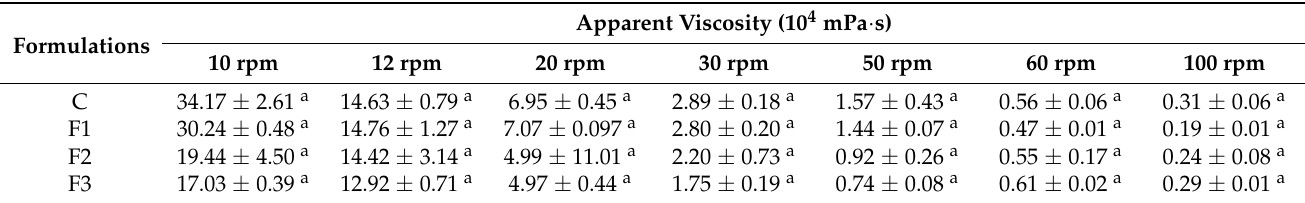
Table 6. Apparent viscosity of control and GABA-enriched dark chocolates.